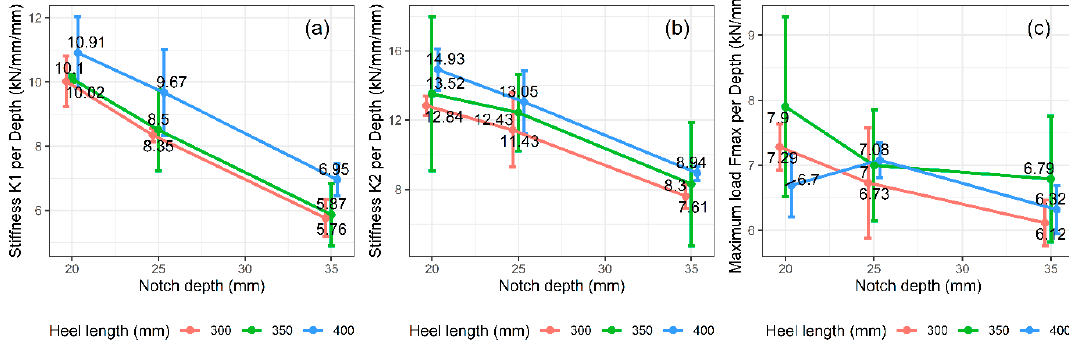
Figure 8. Sti ff ness K1 ( a ), K2 ( b ), and maximum load Fmax ( c ) per notch depth of di ff erent heel Figure 8. Stiffness K1 ( a ), K2 ( b ), and maximum load Fmax ( c ) per notch depth of different heel lengths.